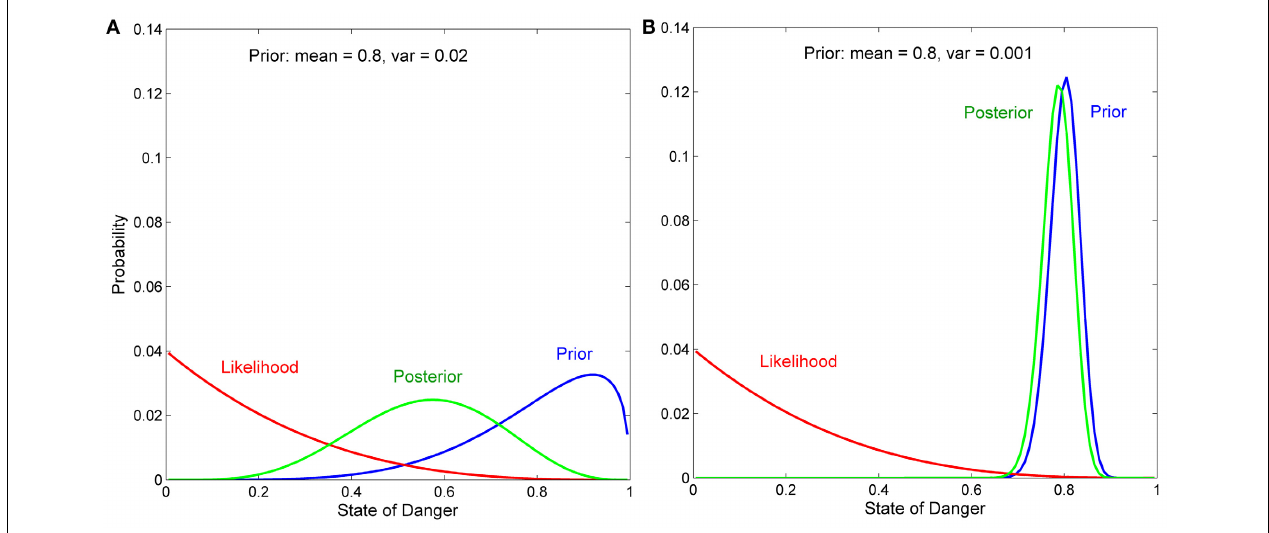
FIGURE A2 | Effect of the variance of the prior distribution on Bayesian updating. Two individuals (A,B) are both exposed to the same experience, with the likelihood function indicated in red. Both individuals have prior distributions with the same mean, but the individual in (A) has a prior distribution with a high variance, whereas